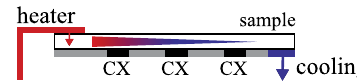
FIG. 9. Sketch of the generation of a temperature gradient over one